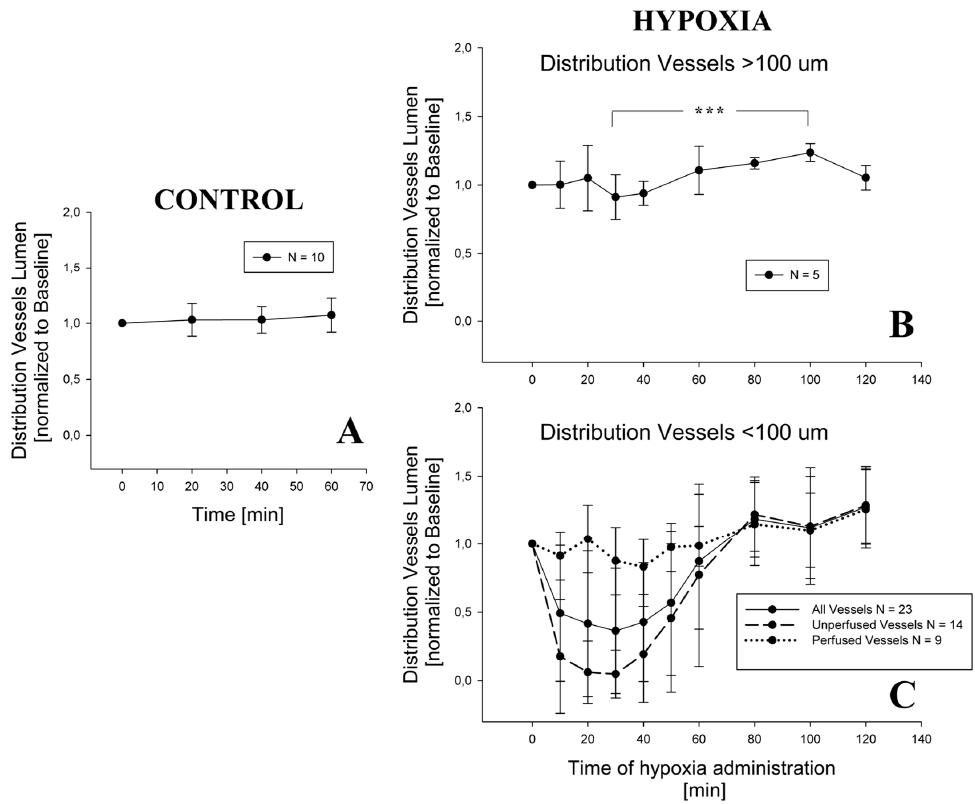
Figure 4. Change in distribution vessels diameter in control condition (Panel A ) and during hypoxia exposure, both for vessels having a diameter > 100 µ m (Panel B ) and for the smaller ones (Panel C ). For graphical reasons, the statistical significance is shown only in Panel B (*** = p < 0,001), while for Panel C see the text. In Panel C, time patterns are shown for distribution vessels that remain patent during the experiment and for those which close at least at one time point.